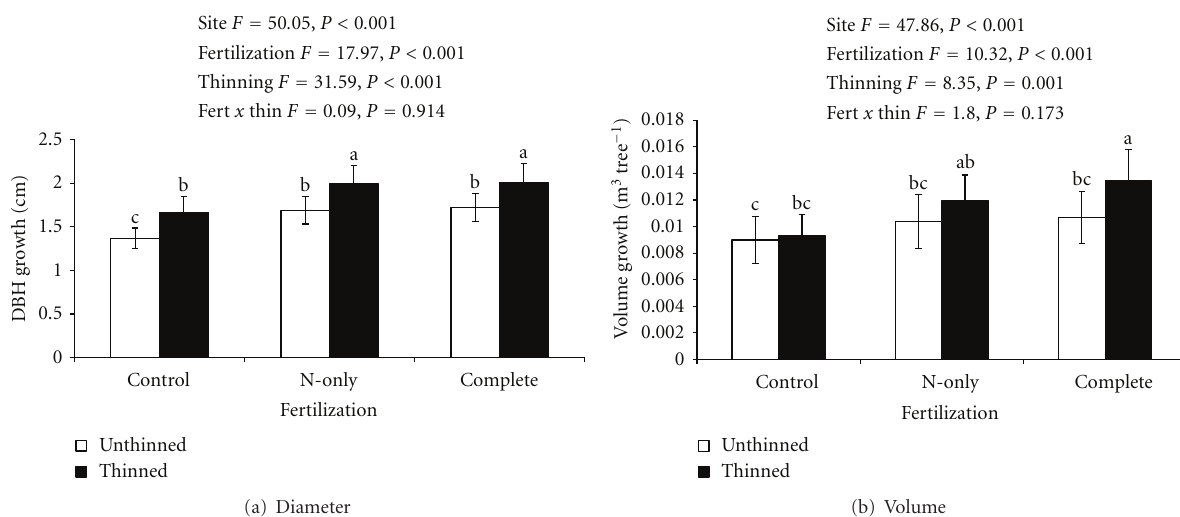
Figure 2: Three-year crop tree diameter (a) and volume (b) growth in relation to thinning and fertilization treatments. Letters represent di ff erences in total growth among the six treatments.